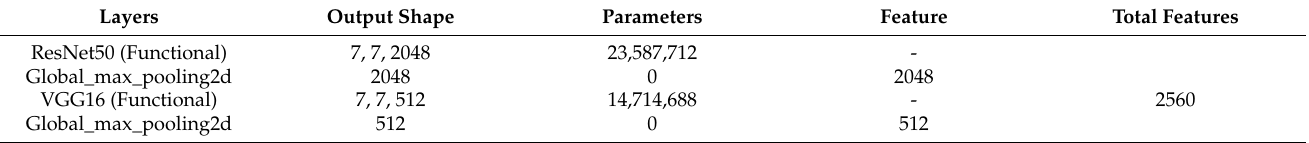
Table 2. Parameters of the network’s